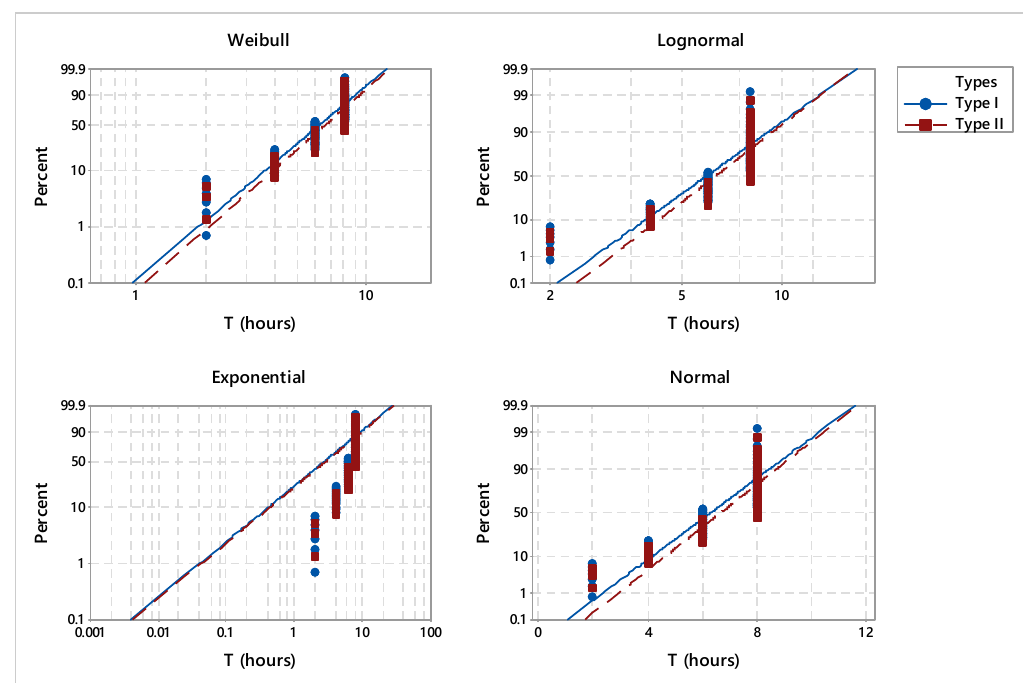
Figure 7. The probability plots of lifetime milling teeth.